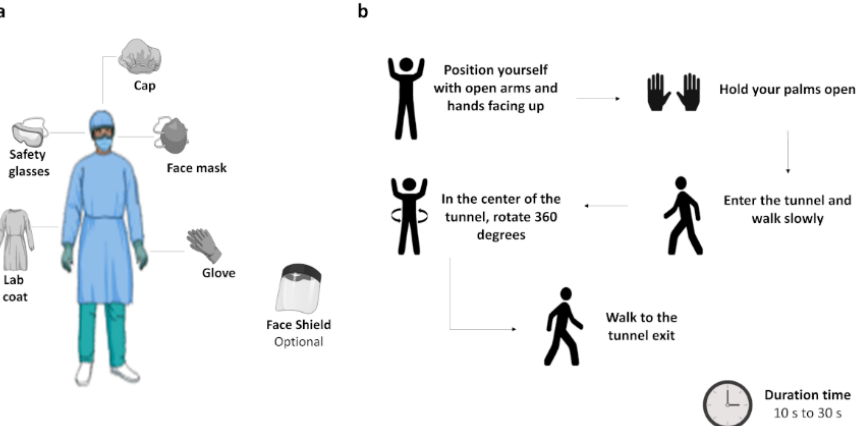
Figure 2. Protocol for the use of the disinfection chamber in hospitals and reference health units designated for the treatment of coronavirus disease (COVID-19) in the state of Bahia (Brazil): ( a ) mandatory use of personal protective equipment (PPE) for use of the chamber—use before the PPE doffing process; ( b ) guidelines for the use of the chamber.